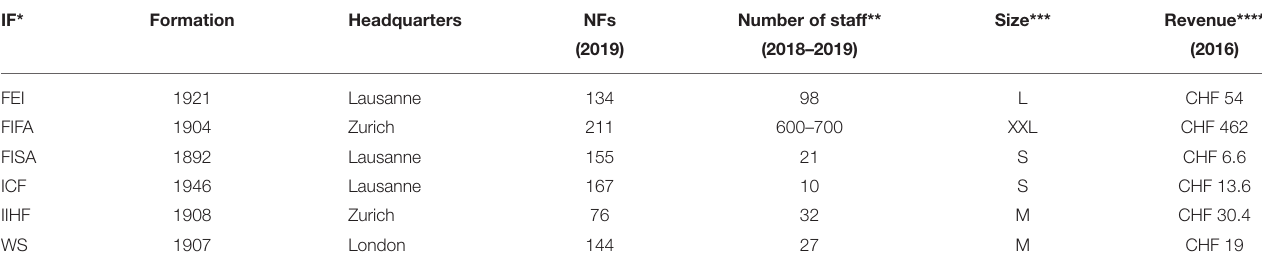
TABLE 1 | IFs selected for case studies.